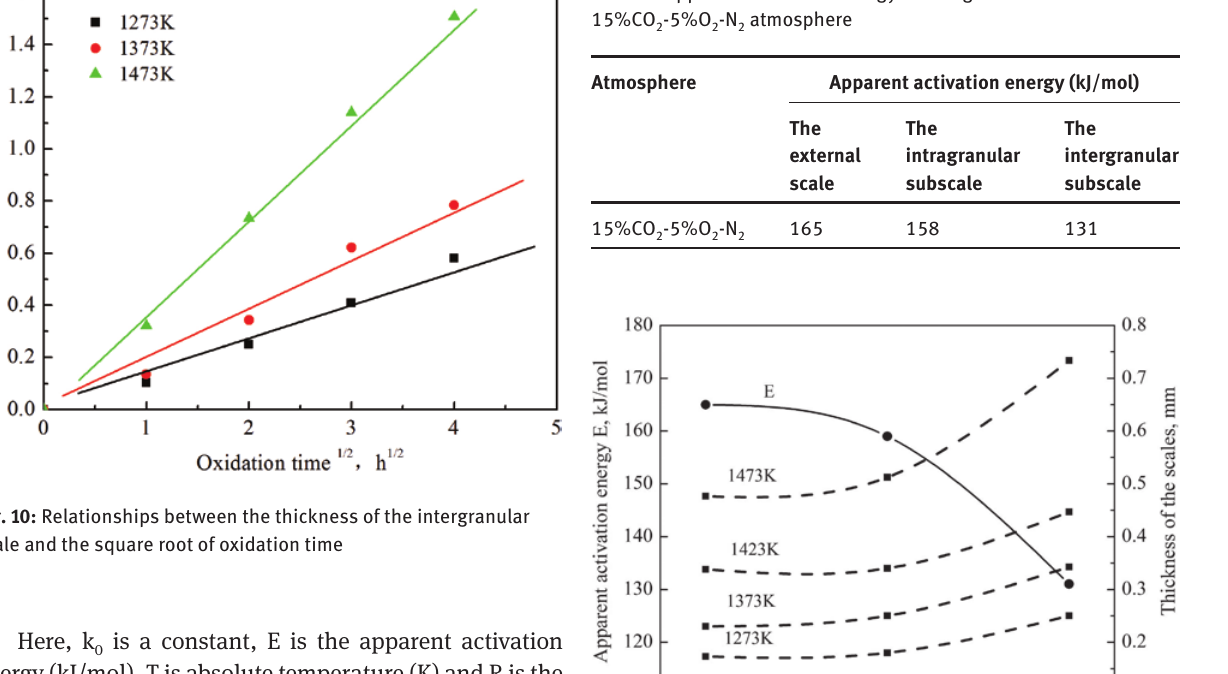
Fig. 11: Arrhenius plots of the growth rate constant versus oxidation temperature